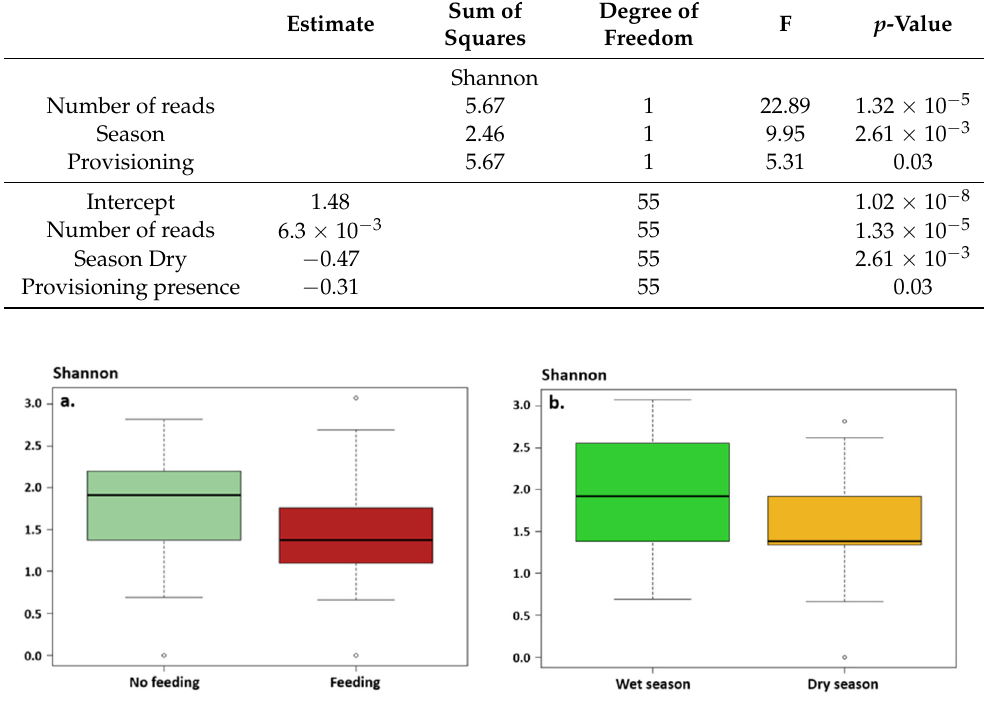
Figure 3. Alpha diversity measured by the Shannon index for ( a ) unfed and fed sharks and ( b ) wet and dry seasons.